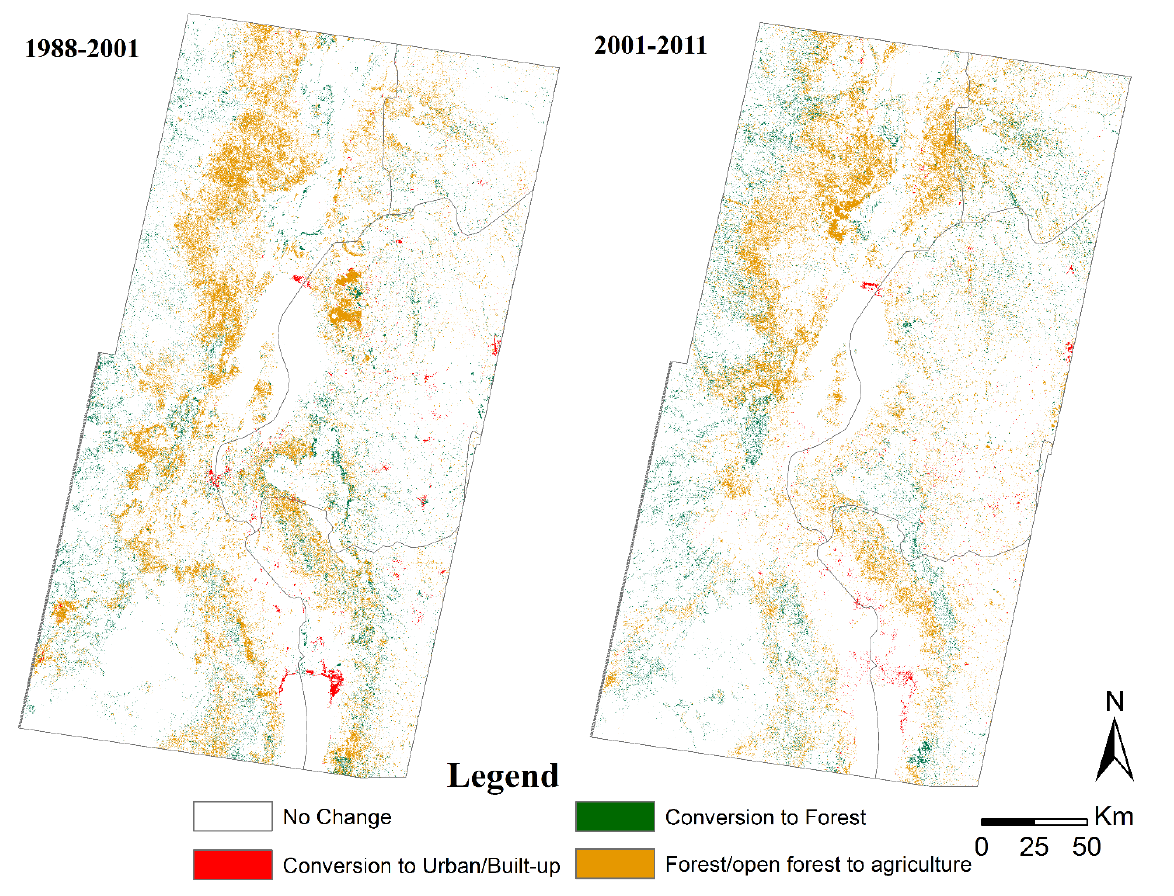
Figure 8. Spatial distribution of land cover change for time period 1988–2001 and